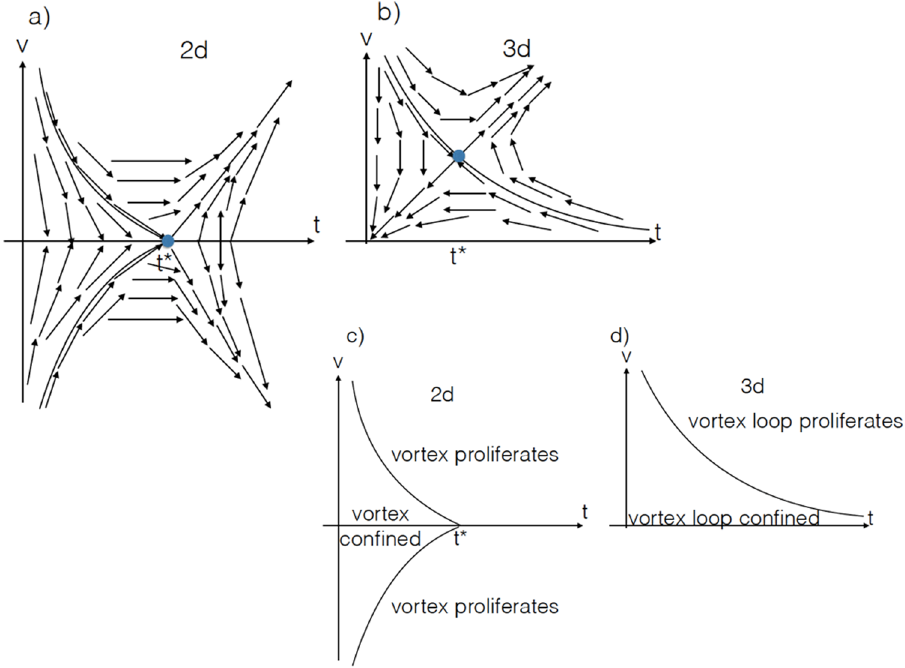
Figure 2. The RG flow and disorder strength-fugacity t - ν phase diagrams of the proliferation of ( a , c ) vortex of 2d XY model in 2d symplectic  TI and ( b , d ) vortex loop of 3d XY model in 3d orthogonal TRI 2